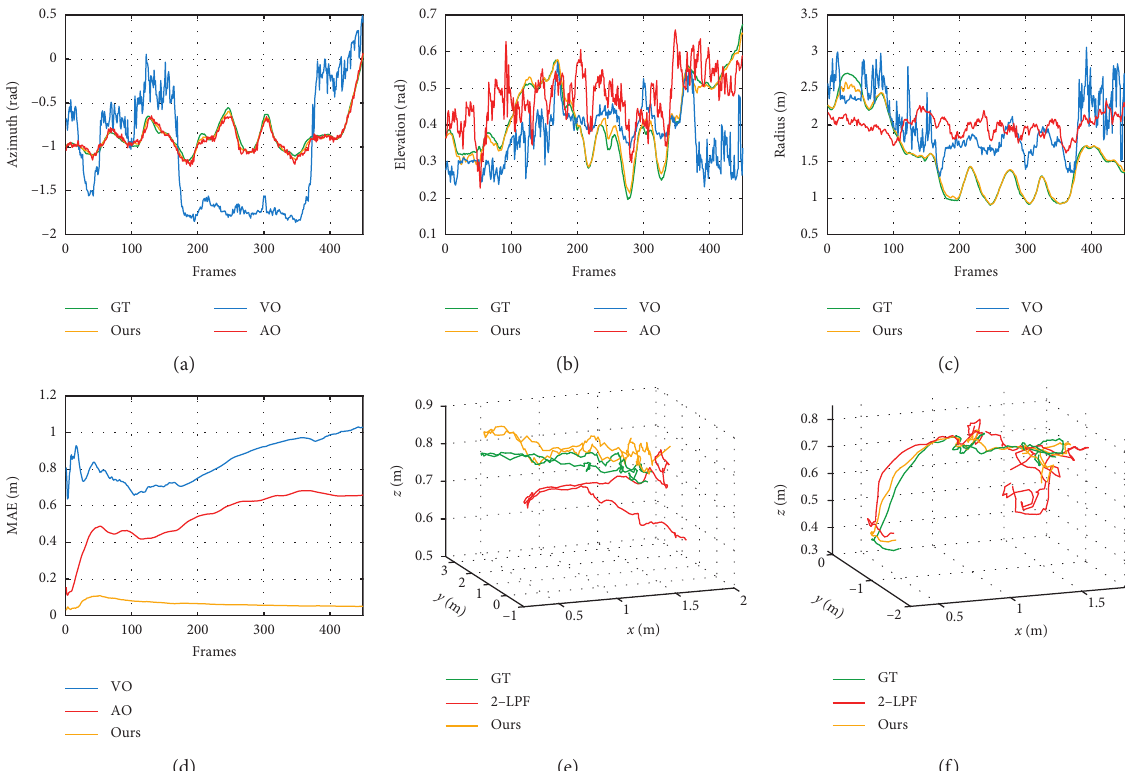
Figure 3: (a–c) 3D tracking results of VO, AO, and AV trackers on azimuth (rad), elevation (rad), and radius (m) on seq11c2, where green line represents ground truth. (d) MAE in 3D (m). (e, f) 3D trajectories on seq08c1 and seq11c2, where green lines indicate ground truth trajectories.